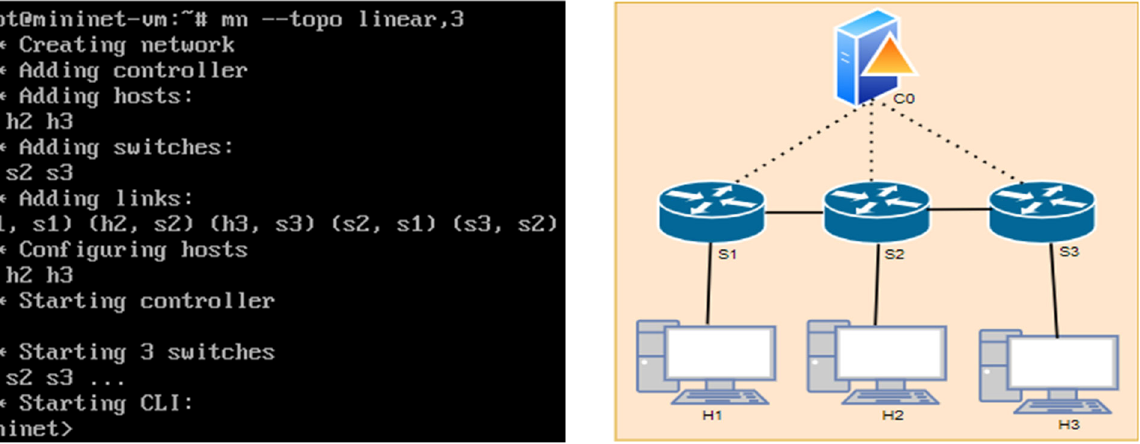
Figure 15. Single topology Mininet command: mn ‐‐ topo single,3.